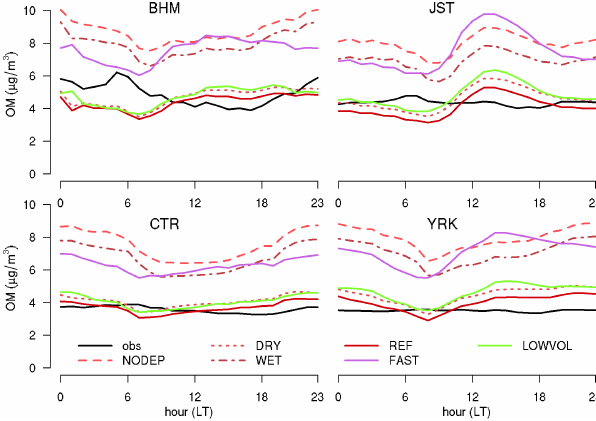
Figure 7. JJA (June, July and August) average diurnal cycles of organic matter (OM) concentrations at 4 field sites of the SEARCH network. Measurements assume an OM / OC ratio of 1.4 (Hansen et al., 2012), model results are scaled accordingly (see